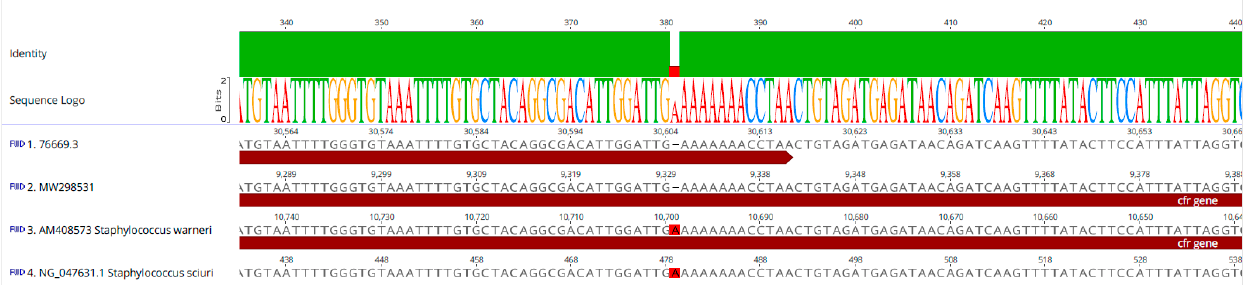
Figure 2. Multiple alignment of the contig-harbouring cfr of the CC398 isolate (ID 76669/3) ( 1 ) with ( 2 ) a 18,240 bp chromosomal region containing cfr ( cfr gene cluster) from S. aureus G322 (MW29853), ( 3 ) a 22,010 bp reference sequence of the Tn558 variant of pSCFS6 plasmid from S. warneri (AM408573), and ( 4 ) a 1250 bp cfr sequence from pSCFS1 plasmid of S. sciuri